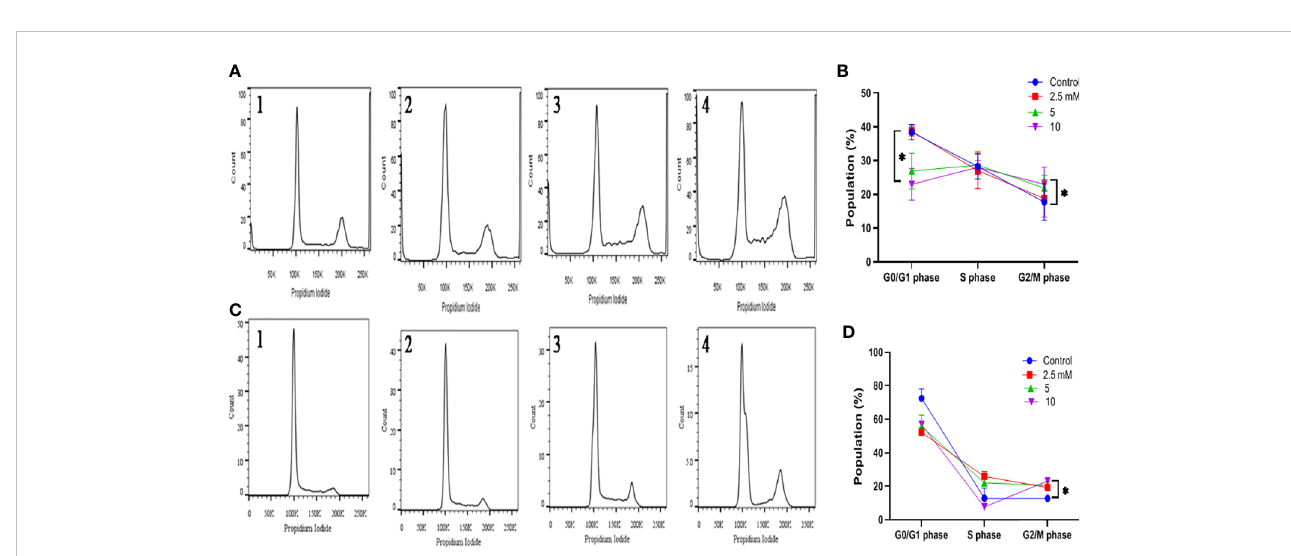
FIGURE 6 Effect of TMA on cell cycle progression. Evaluation of cell cycle HCT116 (A) and HT29 (B) cells were treated with various concentrations of TMA for 48 h. Untreated cells were considered as negative control. (A) and (B) showed the quanti fi cation of cell cycle distribution. TMA induced cell cycle arrest. 1, 2, 3, and 4 represent control, 1.25 mM, 5 mM and 10 mM treatment respectively. The distribution of various phase of HCT116 and HT29 cells are represented in (C, D) Difference of average values between untreated and treated cells were tested using one-way ANOVA. The results (mean±SEM) were obtained from 3 independent experiments. *indicates signi fi cantly different values compared to control group ( P